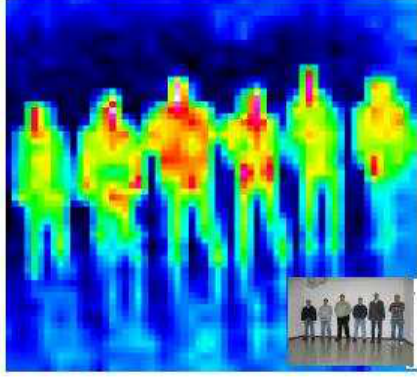
Figure 4. HTPAthermopile image sample and a miniature of its corresponding RGB